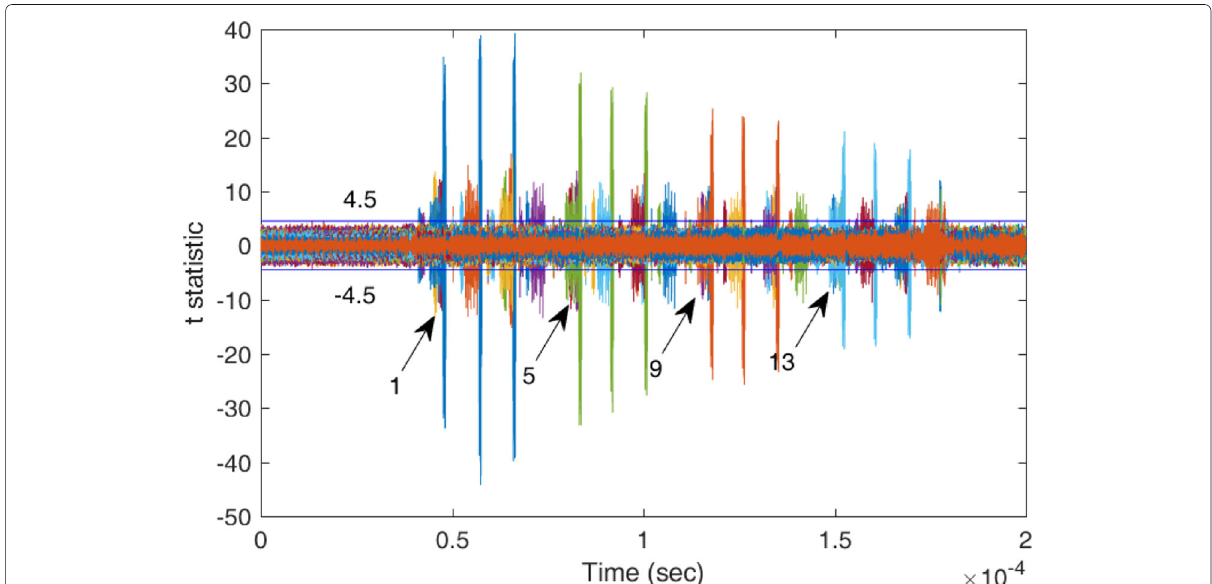
Fig. 5 Experimental results of Welch’s t -test for all 128 bits of 16 intermediate bytes in T 1 G - S 1 G encryption mode